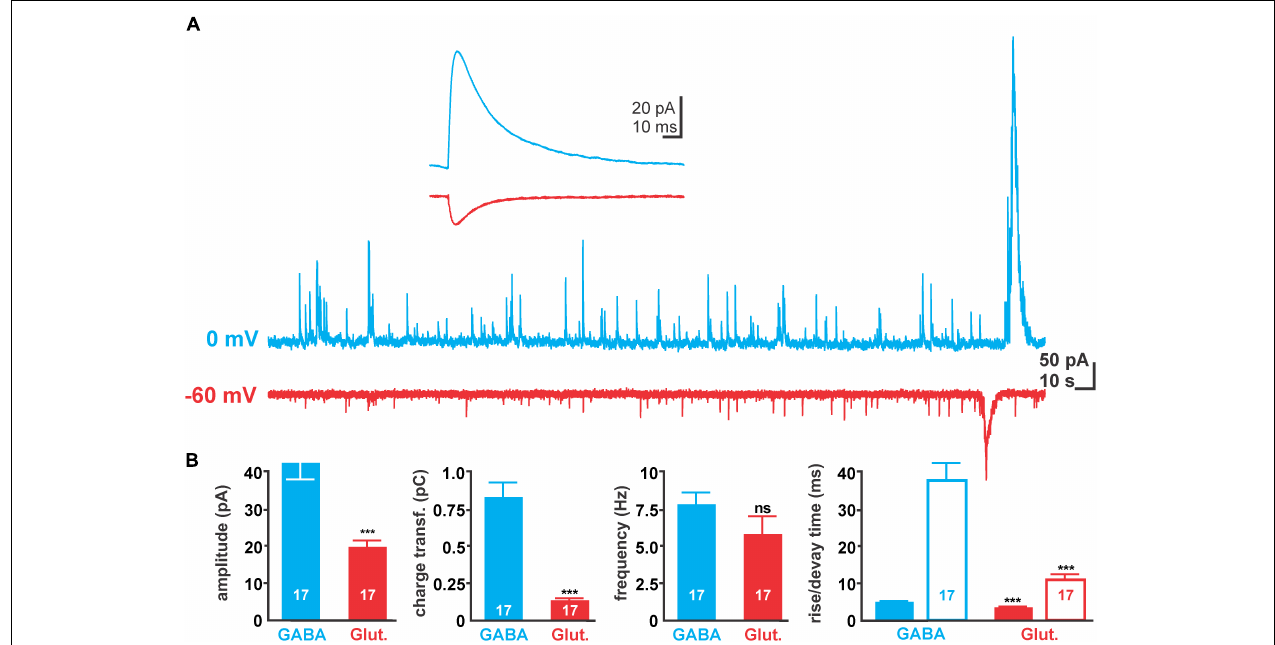
FIGURE 2 | Properties of spontaneous synaptic activity in immature hippocampal slices. (A) Typical spontaneous post-synaptic currents (sPSCs) recorded with 10 mM [Cl − ] p at 0 mV (blue traces) and –60 mV (red traces), reflecting GABAergic and glutamatergic sPSCs, respectively. Note the large current deflections at the end of the traces, which represent GDP-associated currents and were excluded from analysis. (B) Statistical evaluation of amplitude, charge transfer, frequency, and kinetic properties of GABAergic and glutamatergic sPSCs. Glutamatergic currents have smaller amplitude and mediate less charge transfer due to their smaller amplitude and faster decay time (open bars). Bars represent mean ± SEM, numbers of experiments are given in the bars, ∗∗∗ indicates a p -level of < 0.001.